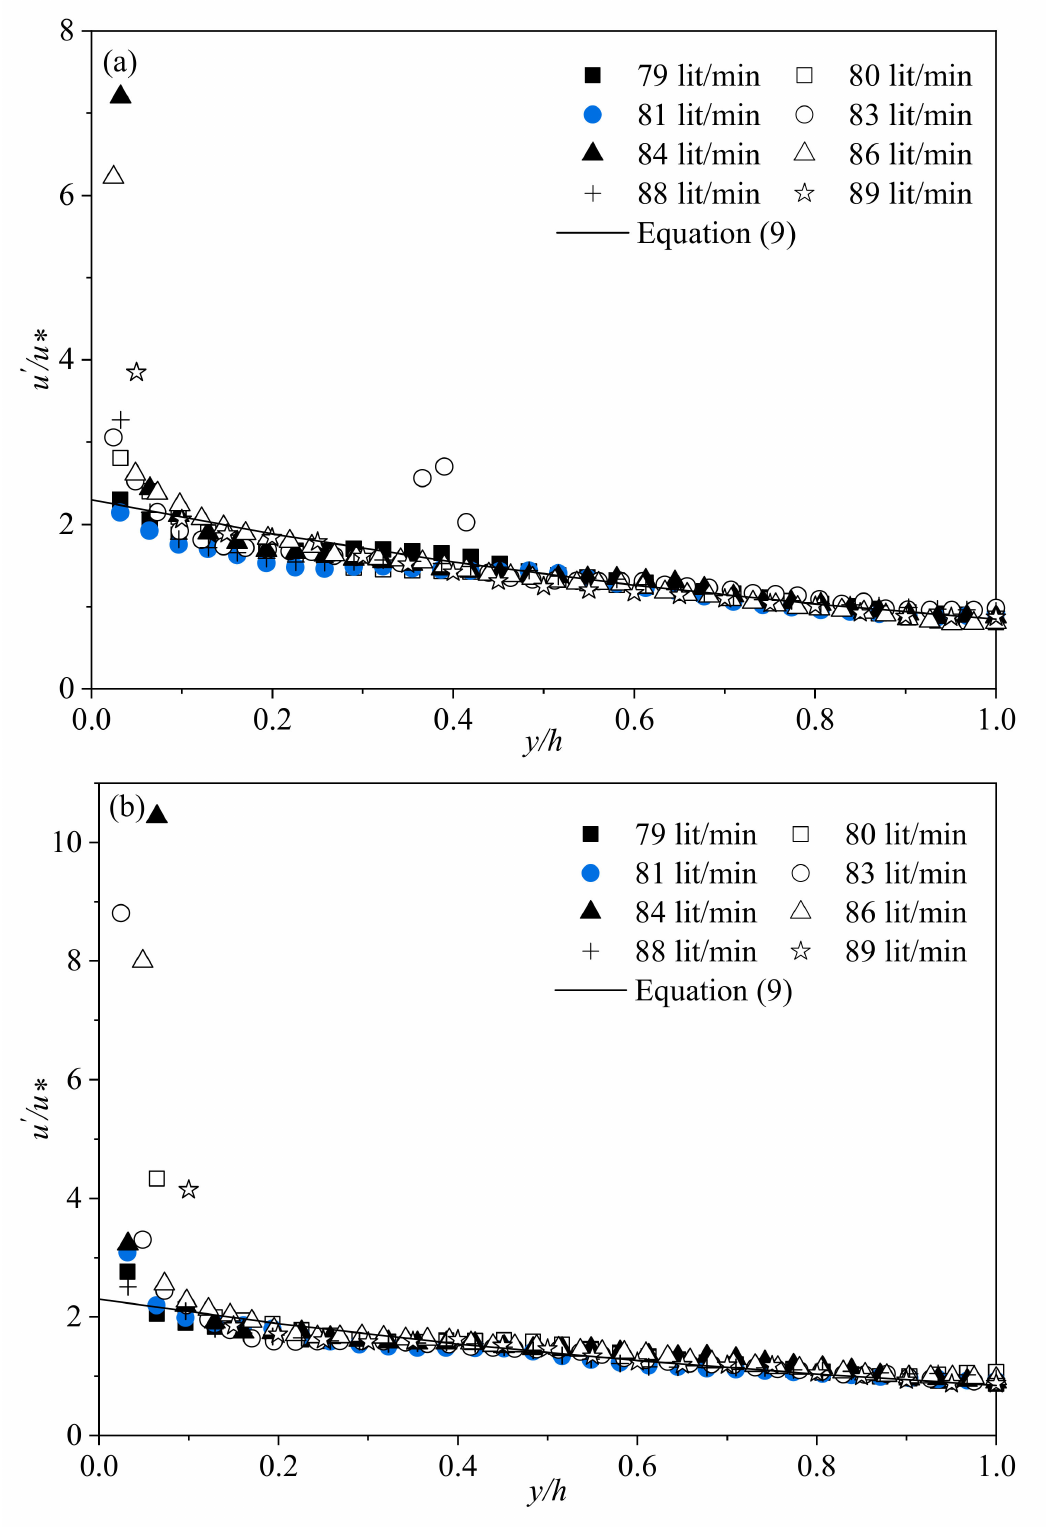
Figure 5. Vertical distributions of turbulence intensities in x -direction: ( a ) sand zone; and ( b ) smooth